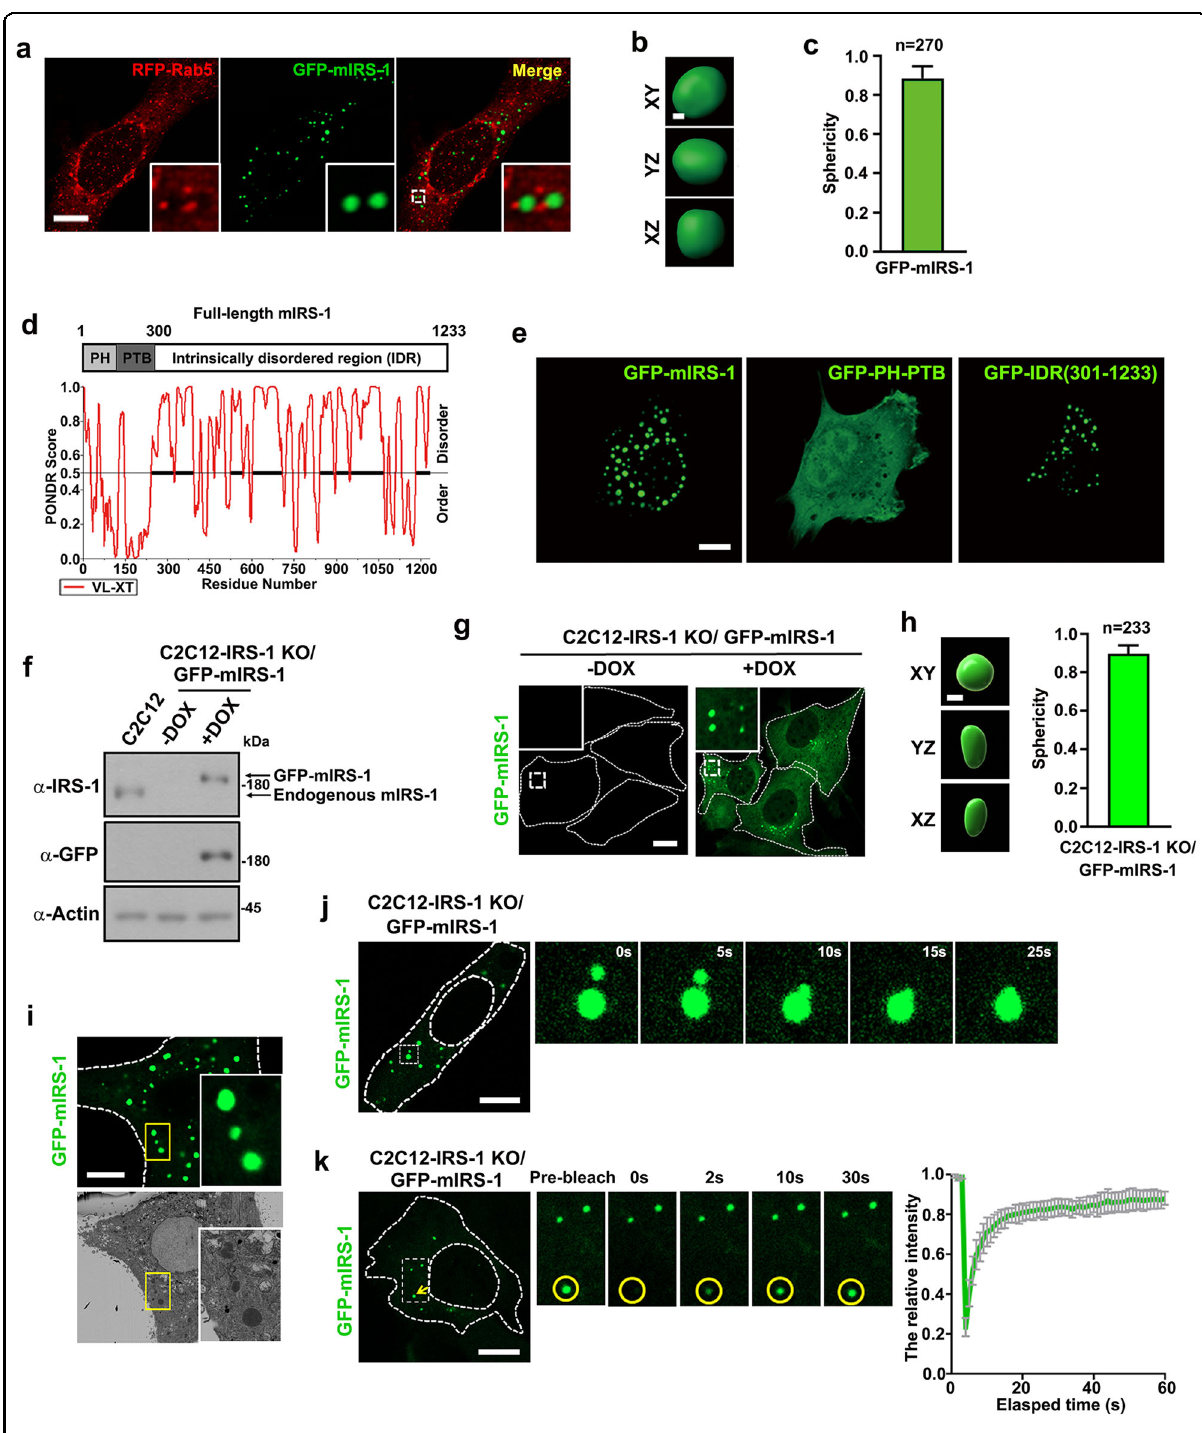
Fig. 1 (See legend on next